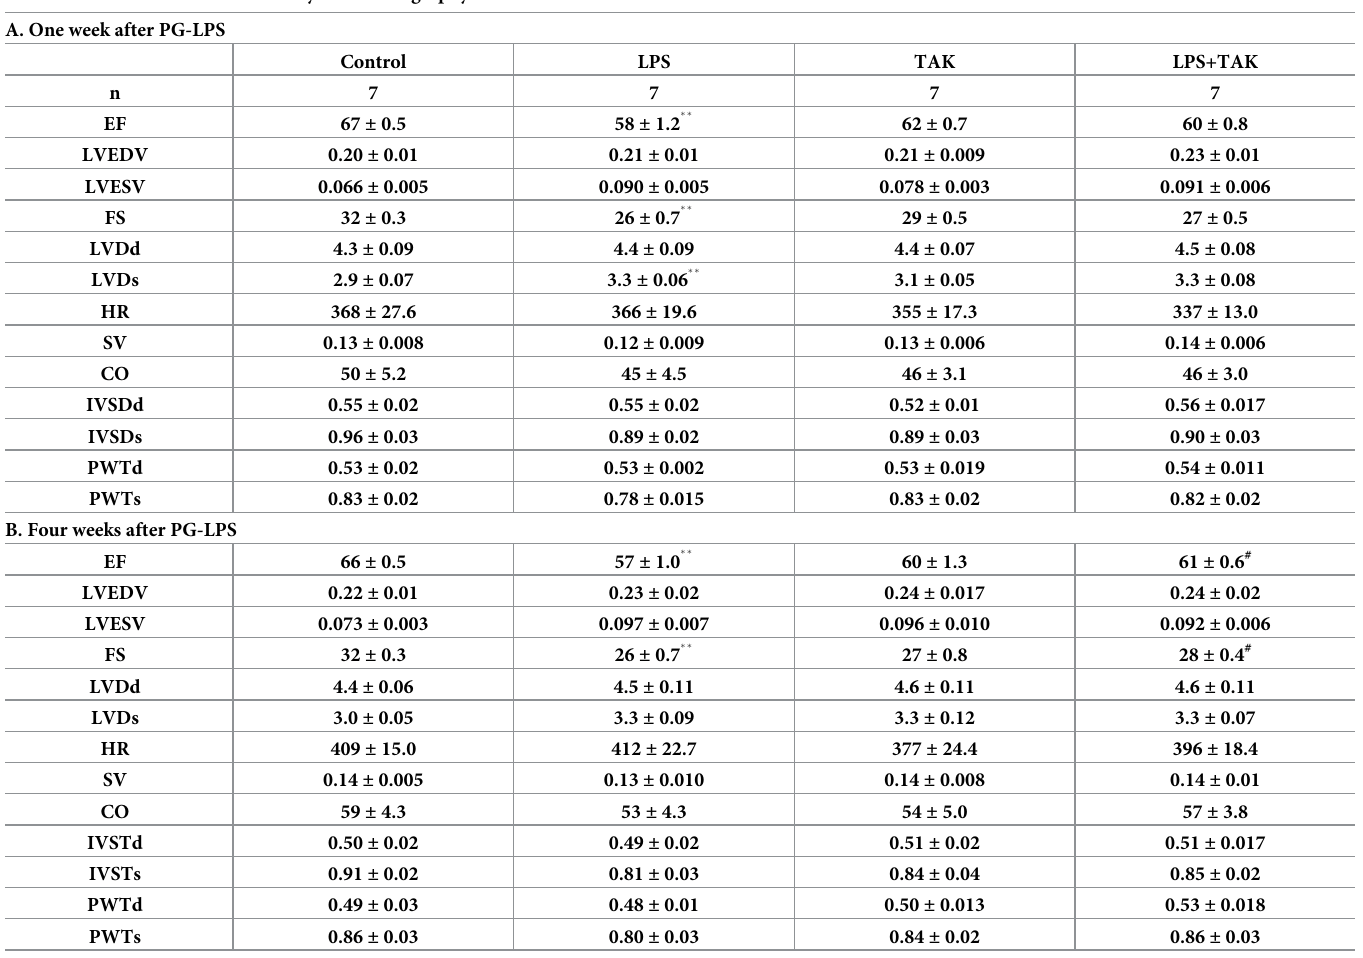
Table 2. Cardiac function assessed by